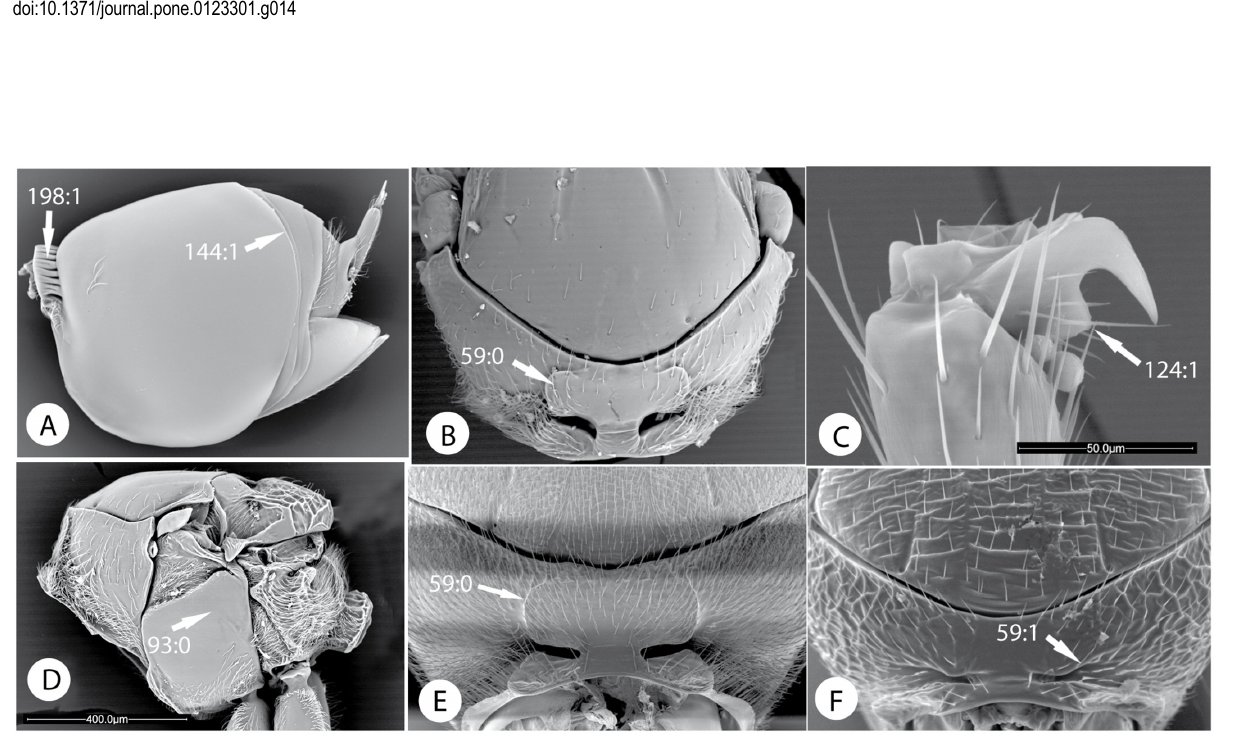
Fig 15. Morphological characters of Diastrophini and Synergini sensu stricto. A) Metasoma in lateral view of Xestophanes potentillae . B) pronotum in anterior view of Xestophanes potentillae . C) metatarsal claw of Diastrophus rubi . D) mesosoma in lateral view of Xestophanes potentillae . E) pronotum in anterior view of Periclistus brandtii (Ratzeburg). F) pronotum in anterior view of Rhoophilus loewi (Mayr).